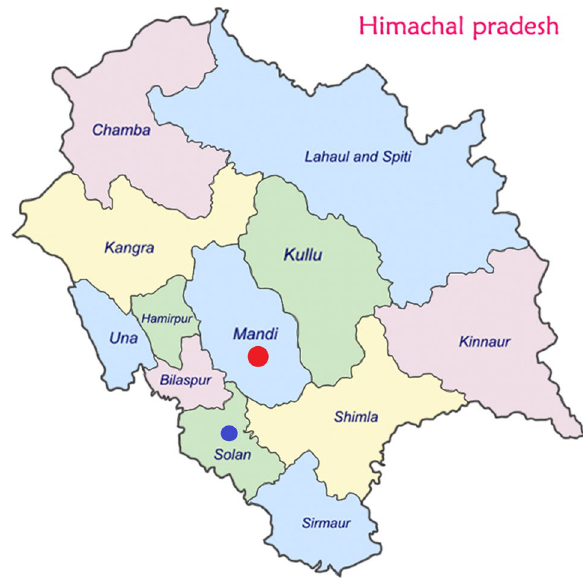
Fig. 1 Location map of study areas (Himachal Pradesh,